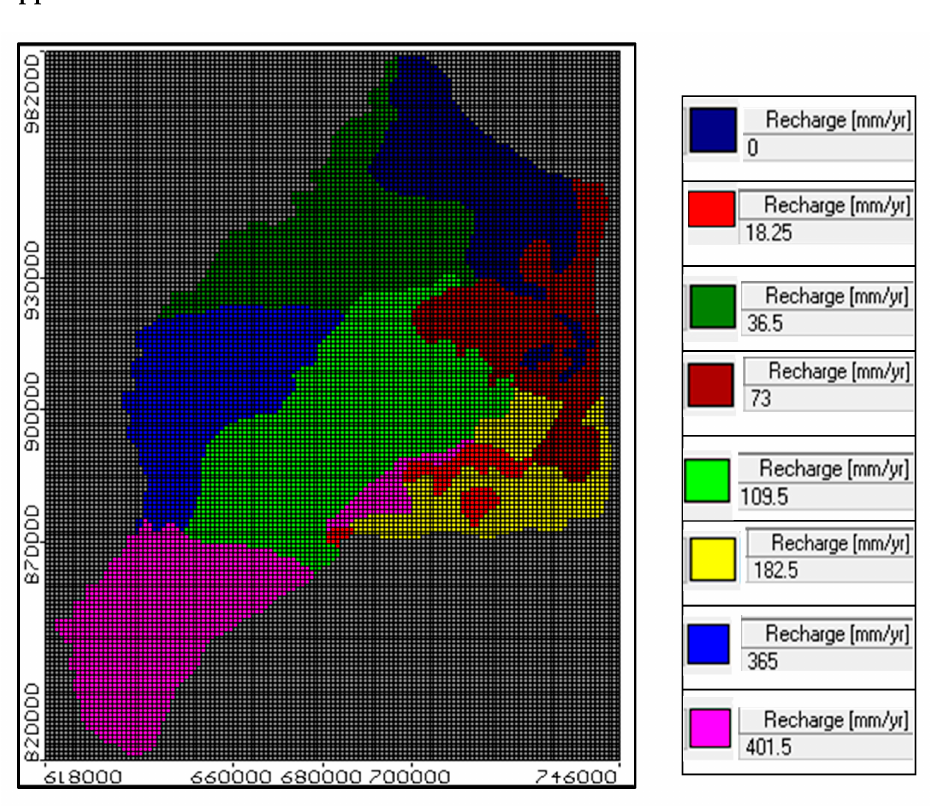
Figure A1. Recharge distribution in the ENDA.